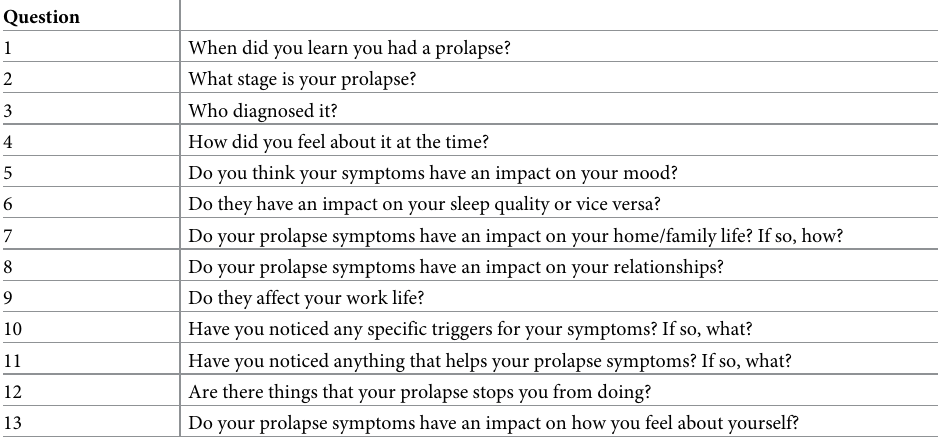
Table 1. Structured interview